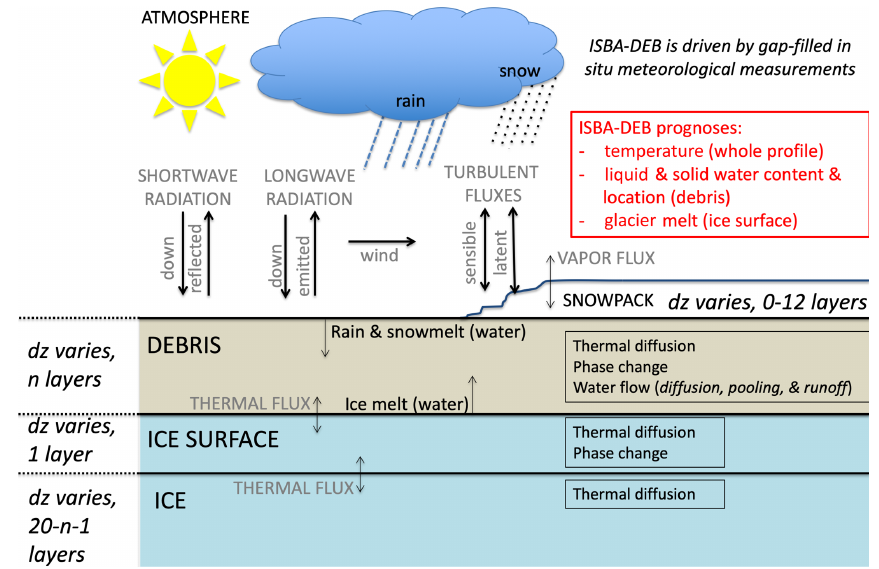
Figure 3. General scheme of ISBA-DEB with fluxes and physical processes. Note that ISBA-DEB is a point-scale model but that the schematic is shown in 2D for interpretability. Precipitation comprises part of the system’s mass flux and affects debris surface properties; however, the heat it carries is not included in the surface energy budget. This schematic shows the user options for ISBA-DEB. In this study, we use 13 debris layers of 1cm, an ice surface layer of 1cm, and six additional ice layers (total 20 layers) of varying thicknesses reaching to a depth of